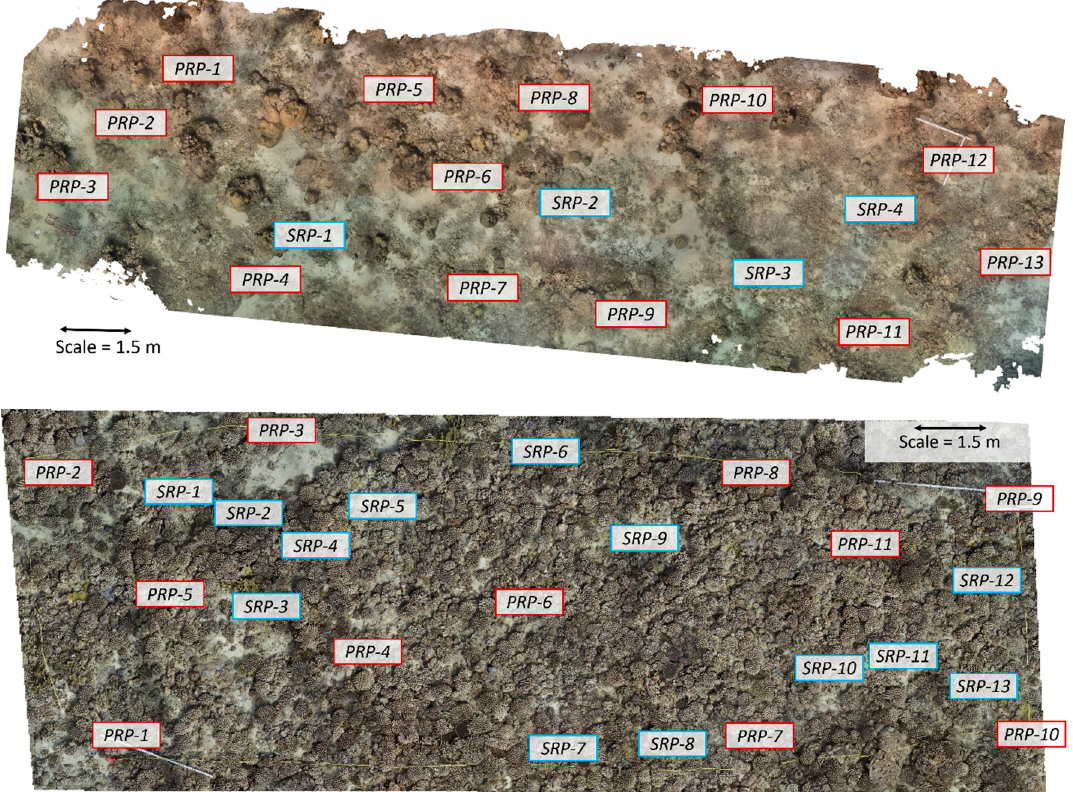
Figure 3. Primary (PRP-x in red) and secondary (SRP-x in blue) reference point distributions within the approximately 16 × 8 m fringing reef (upper panel) and 20 × 5 m fore reef (lower panel) plots.